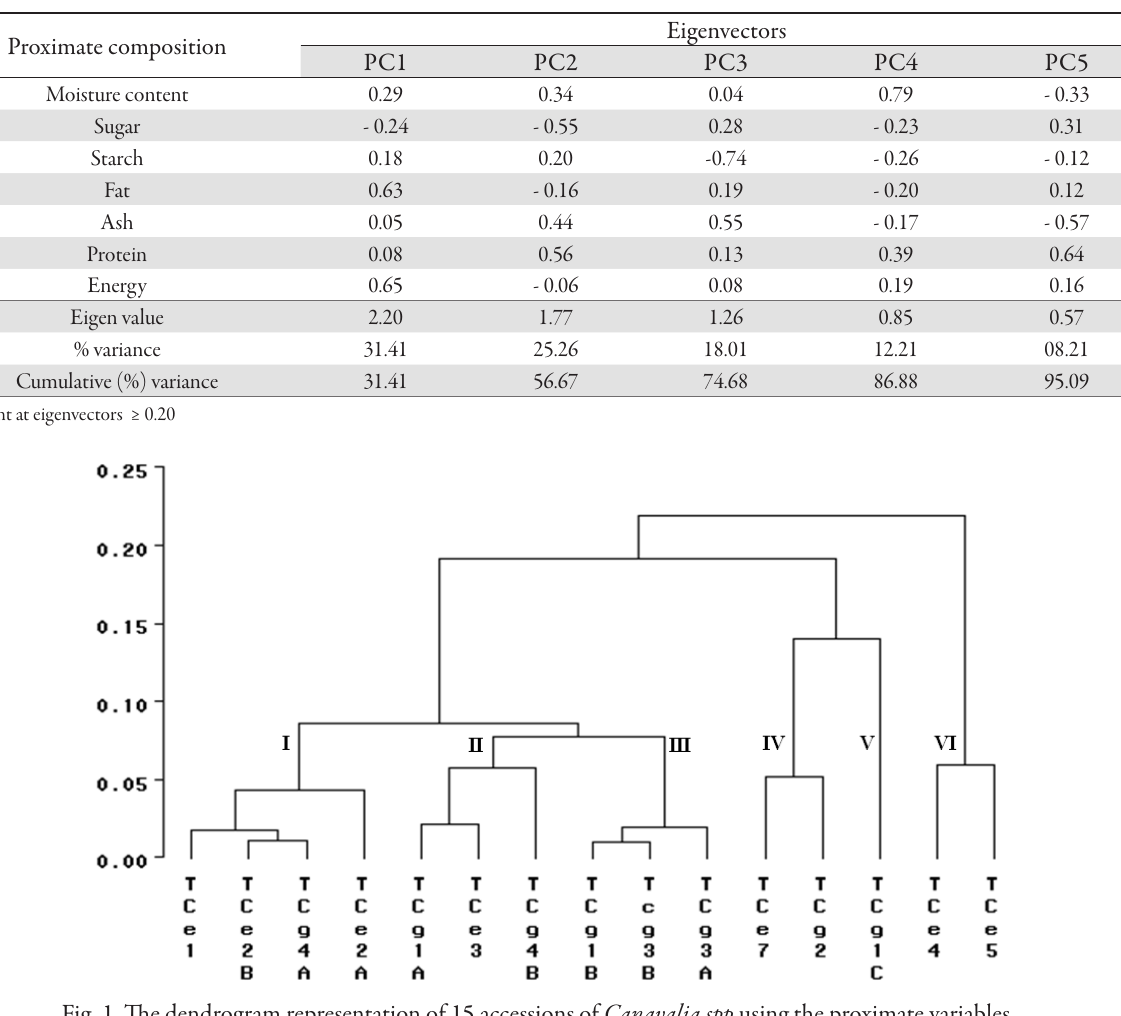
Fig. 1. The dendrogram representation of 15 accessions of Canavalia spp using the proximate